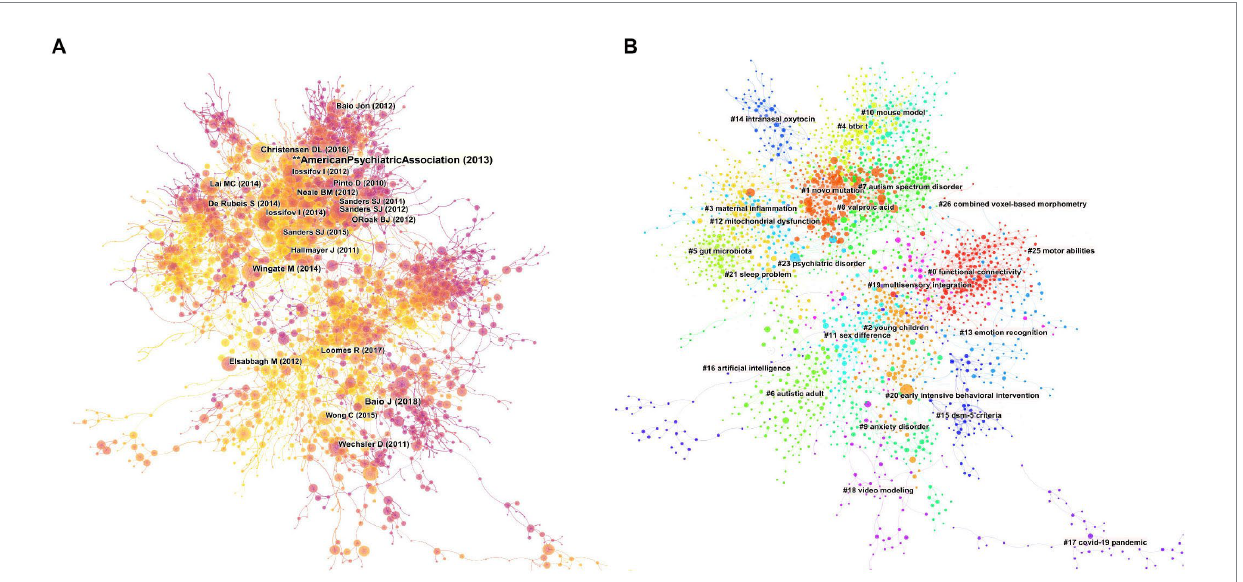
FIGURE 5 Mapping on co-cited references. (A) A network map showing the co-cited references. (B) Co-cited clusters with cluster